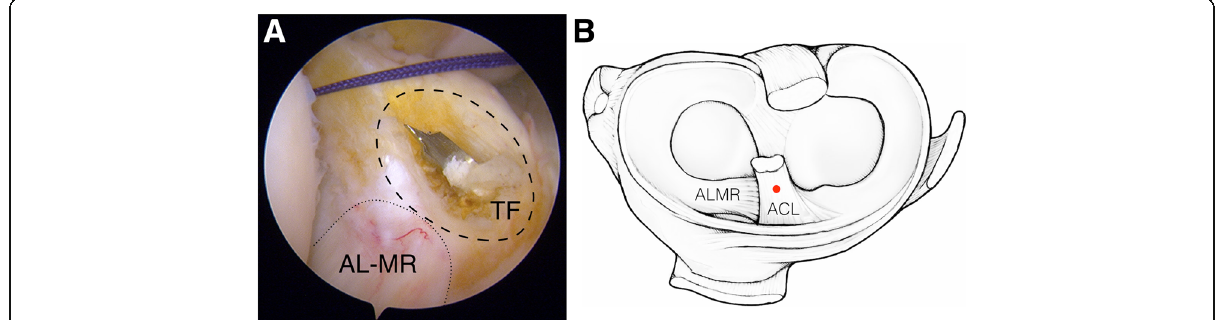
Fig. 1 Tibial footprint center. Prior to tunnel drilling, the tibial insertion site and its peripheral structures, including the anterior root of the lateral meniscus (ALMR), were carefully examined to identify the center of the tibial footprint (TF). This point was regularly 2 to 3 mm anteromedial to the posterior margin of the ALMR ( a : arthroscopic view; b : schematic